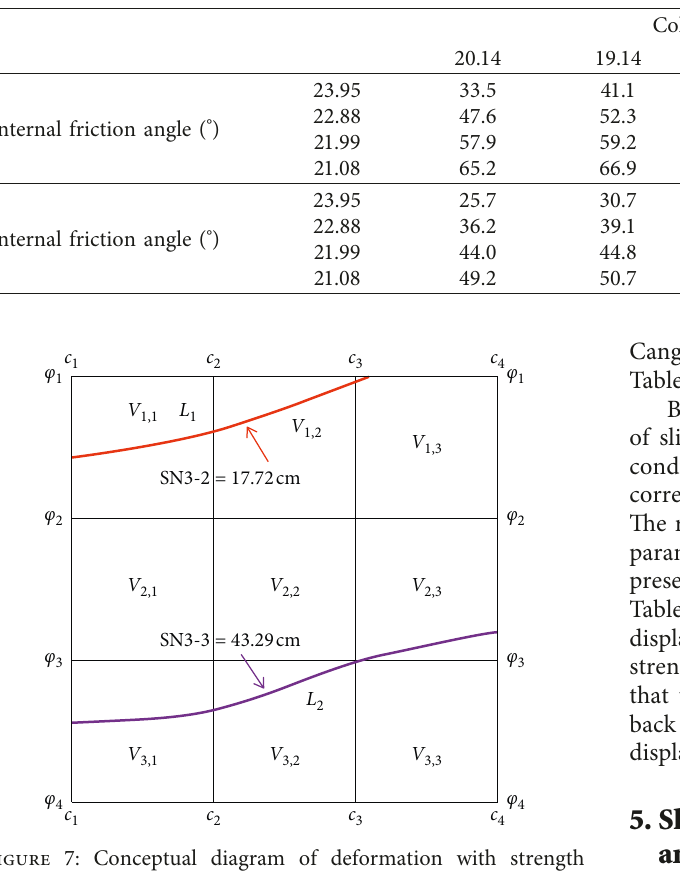
Table 6: Calculated deformation values of Dahua landslide (mm).